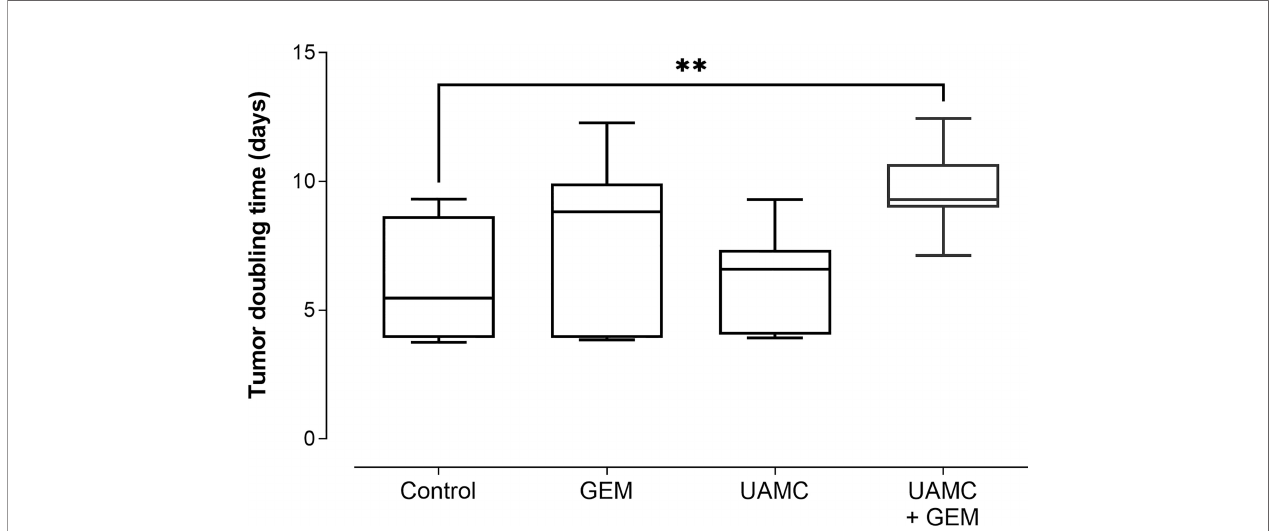
FIGURE 5 | Tumor doubling time. C57/BL6 mice with Panc02 tumors were treated with vehicle (control), UAMC-2526 (UAMC), gemcitabine (GEM) or a combination of UAMC-2526 and gemcitabine. After treatment, tumor doubling time was calculated. Number of animals in each group was between 8-10. Data were analyzed with one-way ANOVA. Signi fi cant values of post hoc comparison were adjusted using Dunnett ’ s correction. **p ≤ 0.01 versus control group.